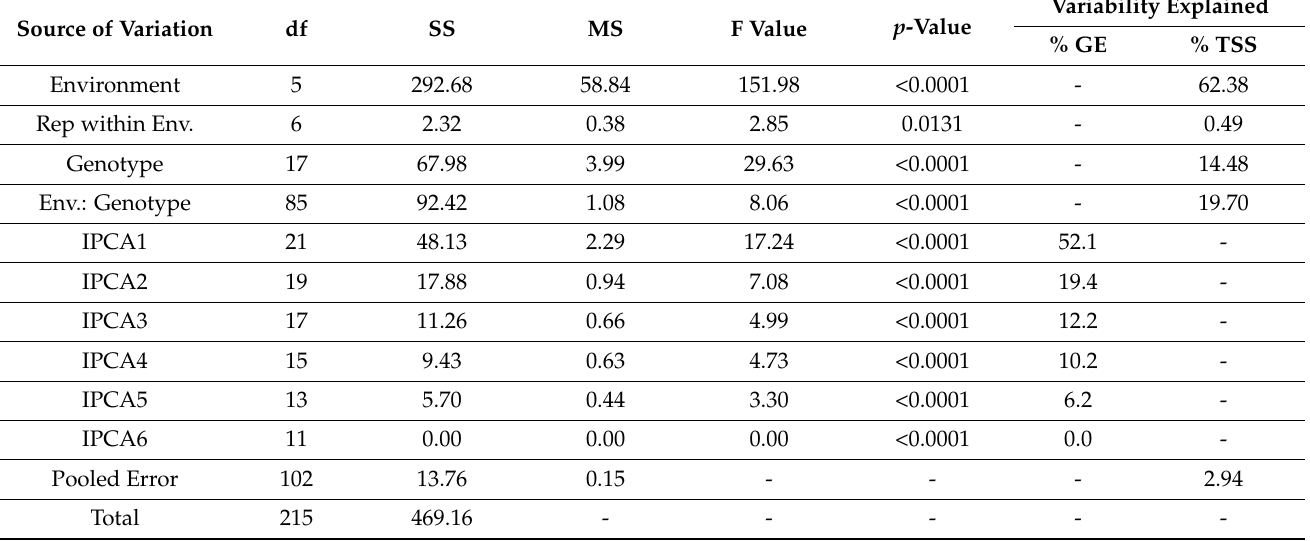
Table 2. Additive main effects and multiplicative interaction (AMMI) analysis of variance for grain yield (t/ha) of 18 elite rice genotypes throughout six different environments in two years.